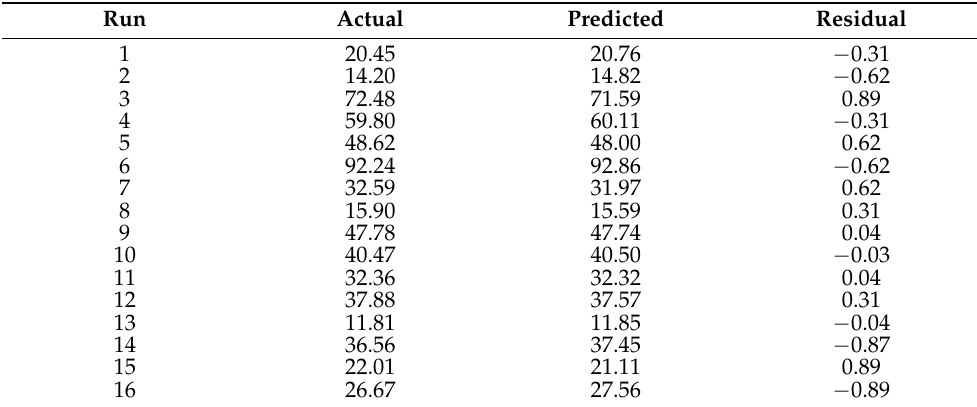
Table 9. Predicted vs. experimental response for the equilibrium adsorption capacity of